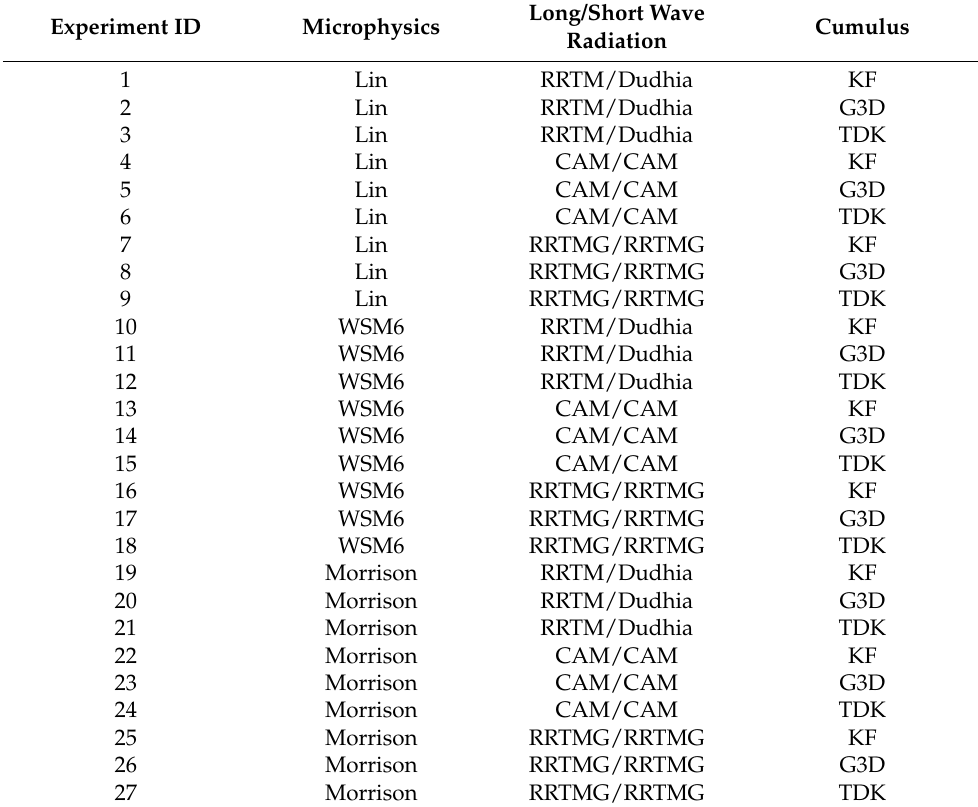
Table 4. Twenty-seven physical parameterization combinations for typhoon simulation